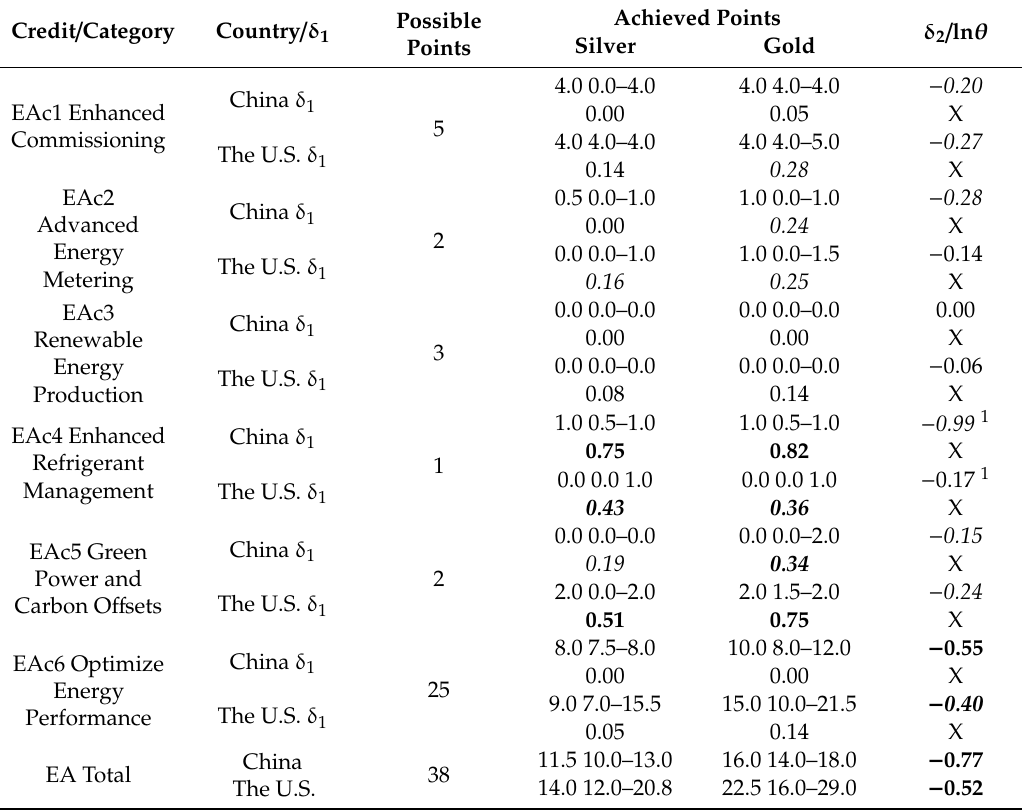
Table 6. LEED-CIv4 Energy and Atmosphere (EA) credits category: The median and 25th–75th centiles and Cli ff ’s e ff ect size ( δ 1 ) of the di ff erence between the achieved and the possible points, and ( δ 2 ) or ln θ of the di ff erence between Silver and Gold projects in China and the U.S. Country / δ